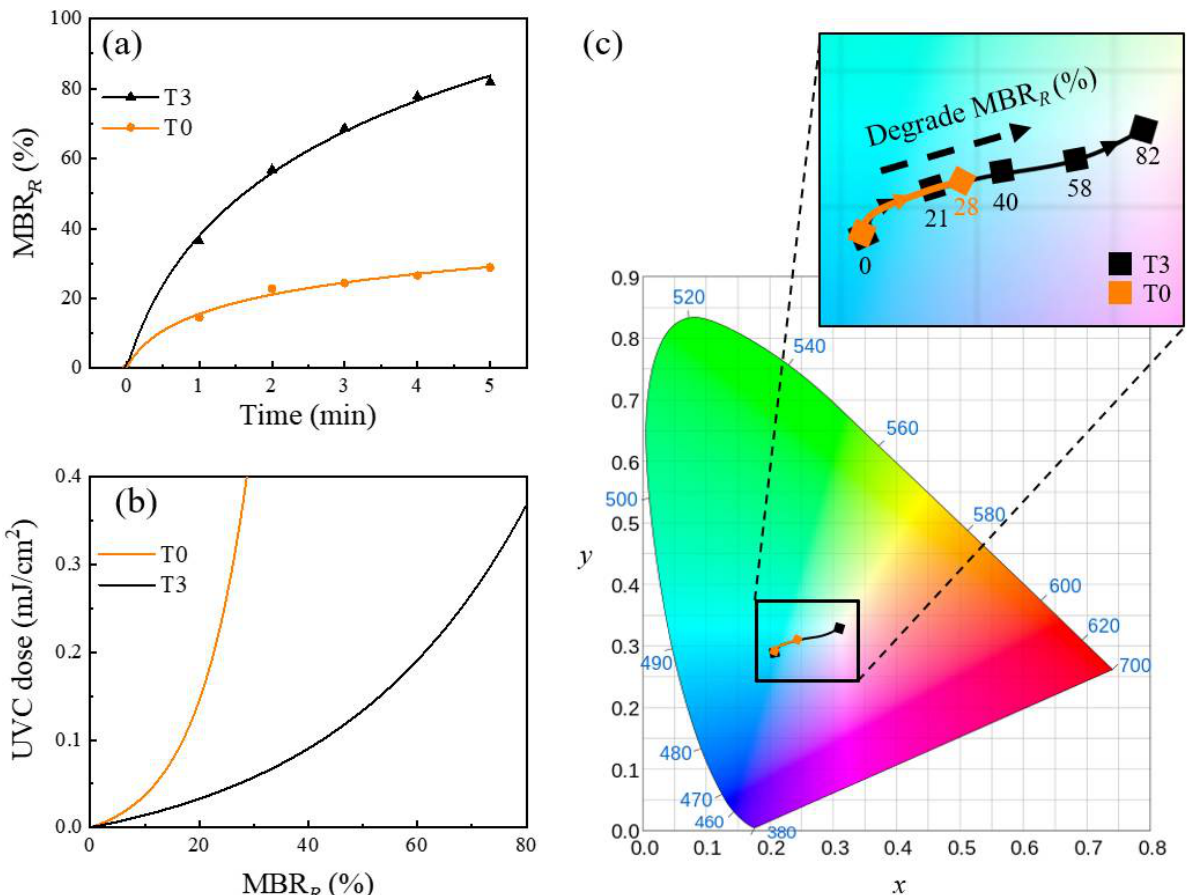
Figure 4. ( a ) MBR R of T0 and T3 as a function of the UVC irradiation time (0–5 min). ( b ) Accumulated UVC dose (mJ/cm 2 ) as a function of the simulated MBR R values depending on T0 and T3; the intensity of the UVC radiation was 1.38 mW/cm 2 . ( c ) MBR R changes of T0 and T3 in the International Commission on Illumination (CIE) chromaticity diagram after 5 min of UVC exposure.